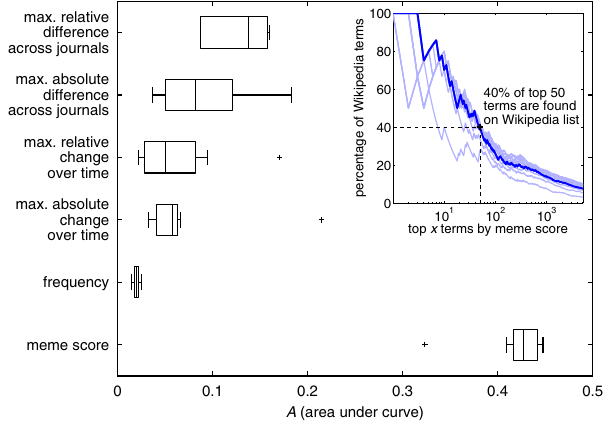
FIG. 3. The meme score outperforms alternative metrics. The box plot shows the agreement with the ground-truth list of physics terms extracted from Wikipedia as achieved by the different metrics. Agreement is measured as the area under the curve A , as shown for the meme score in the embedded graph on the top right. The curves are defined as the percentage from the x top-ranked terms that also appear on the ground-truth list for the different parameter settings ( 1 ≤ δ ≤ 10 for the meme score; the thick line stands for δ ¼ 4 , which has the largest area A ; see Sec. IV for details).